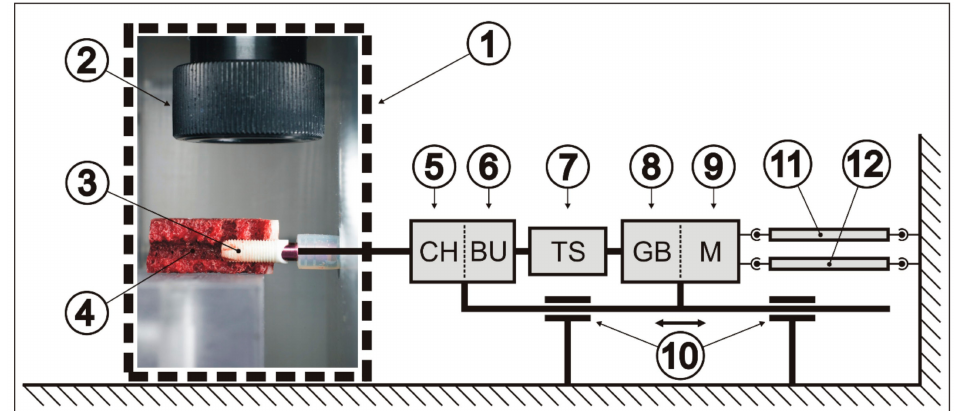
Figure 3. Diagram of the experimental setting. ( 1 ) Thermo box; ( 2 ) lens of infrared camera; ( 3 ) fully inserted ceramic implant; ( 4 ) transection of the rib segment; ( 5 ) collet holder (CH); ( 6 ) bearing unit (BU); ( 7 ) torque sensor (TS); ( 8 ) gearbox (GB); ( 9 ) motor (M); ( 10 ) linear bearing; ( 11 ) pneumatic cylinder; ( 12 ) distance